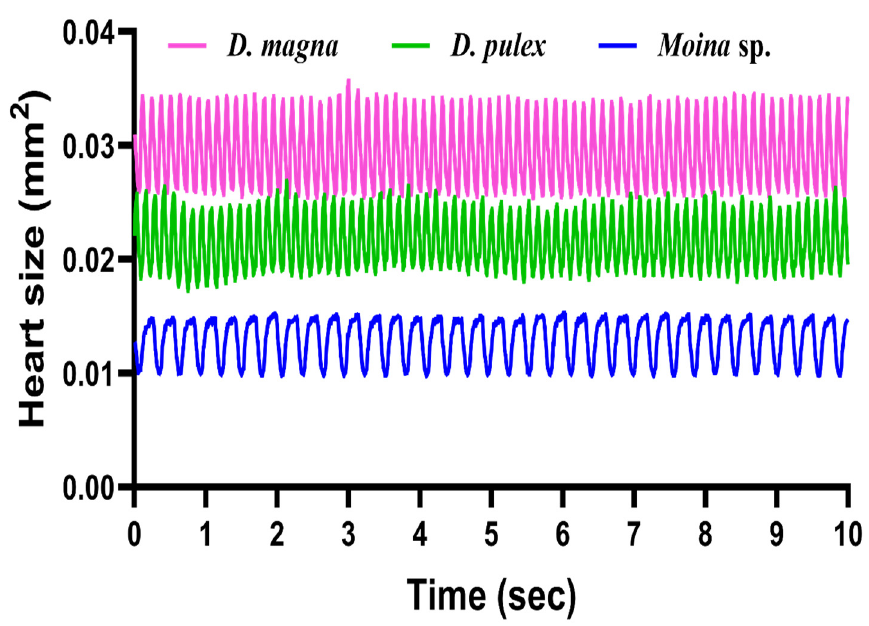
Figure 4. Use Mask RCNN to study cardiac rhythm in water fleas. Three water flea species of D. magna (pink color), D. pulex (green color), and Moina sp. (blue color) were tested, and the cardiac rhythm and heart size change dynamic can be elucidated by the Mask RCNN method.